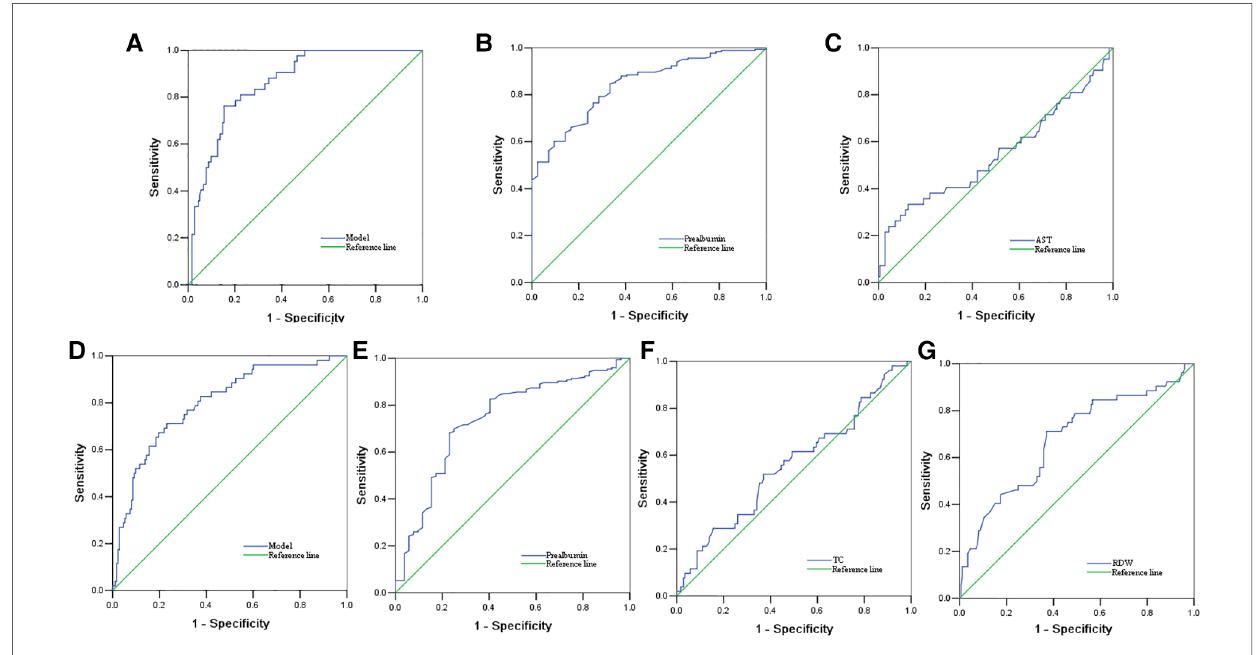
FIGURE 1 Receiver operating characteristic curves. A – C , The model ( A ) and included variables of prealbumin ( B ) and aspartate aminotransferase (AST) ( C ) in the prediction of comprehensive clinical risks. D – G , The model ( D ) and included variables of prealbumin ( E ), total cholesterol (TC) ( F ), and red blood cell distribution width (RDW) ( G ) in the prediction of coronary lesion